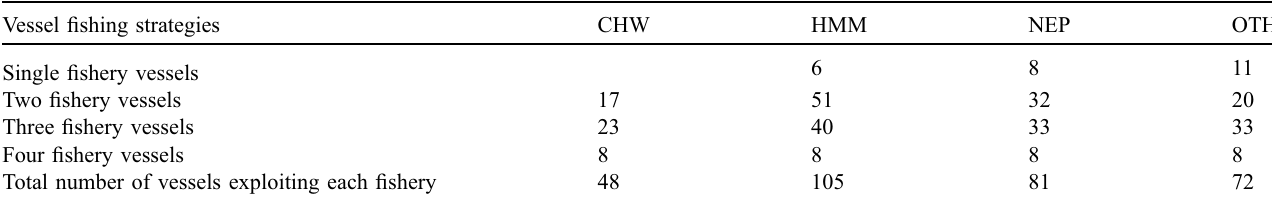
Table 2. Number of vessels of the white fi sh fl eet exploiting each fi shery including count of multiple fi shery exploitation. Vessel fi shing strategies